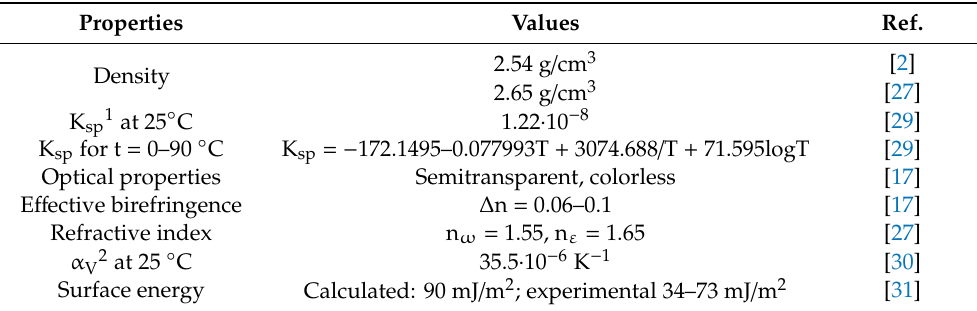
Table 1. Selected properties of